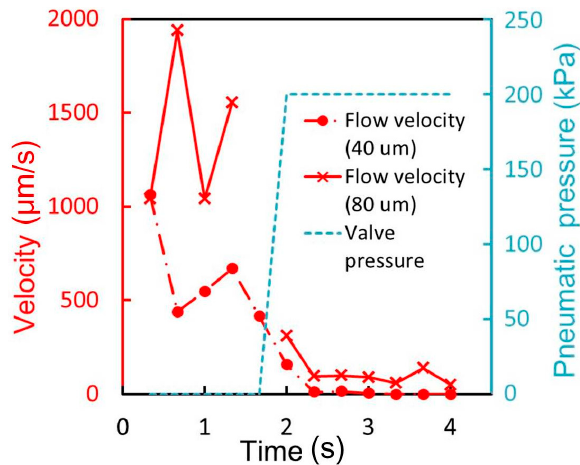
Figure 13. Time variations of the mean velocity of the flowing cells and the pressure applied to the microvalve for membrane thicknesses of 40 and 80 μ m.